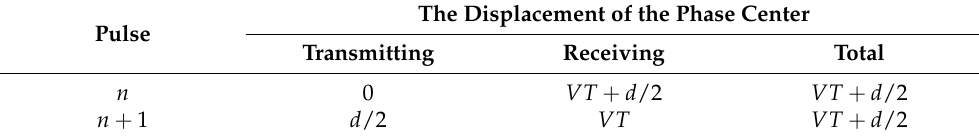
Table 1. DPCA adjacent pulse phase center